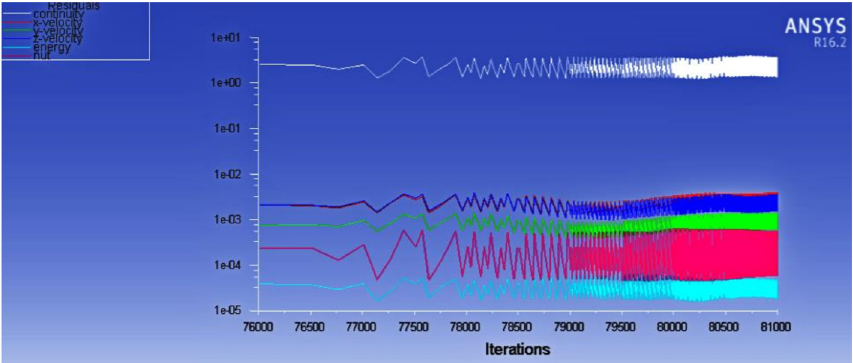
Figure 13. The residuals of the numerical